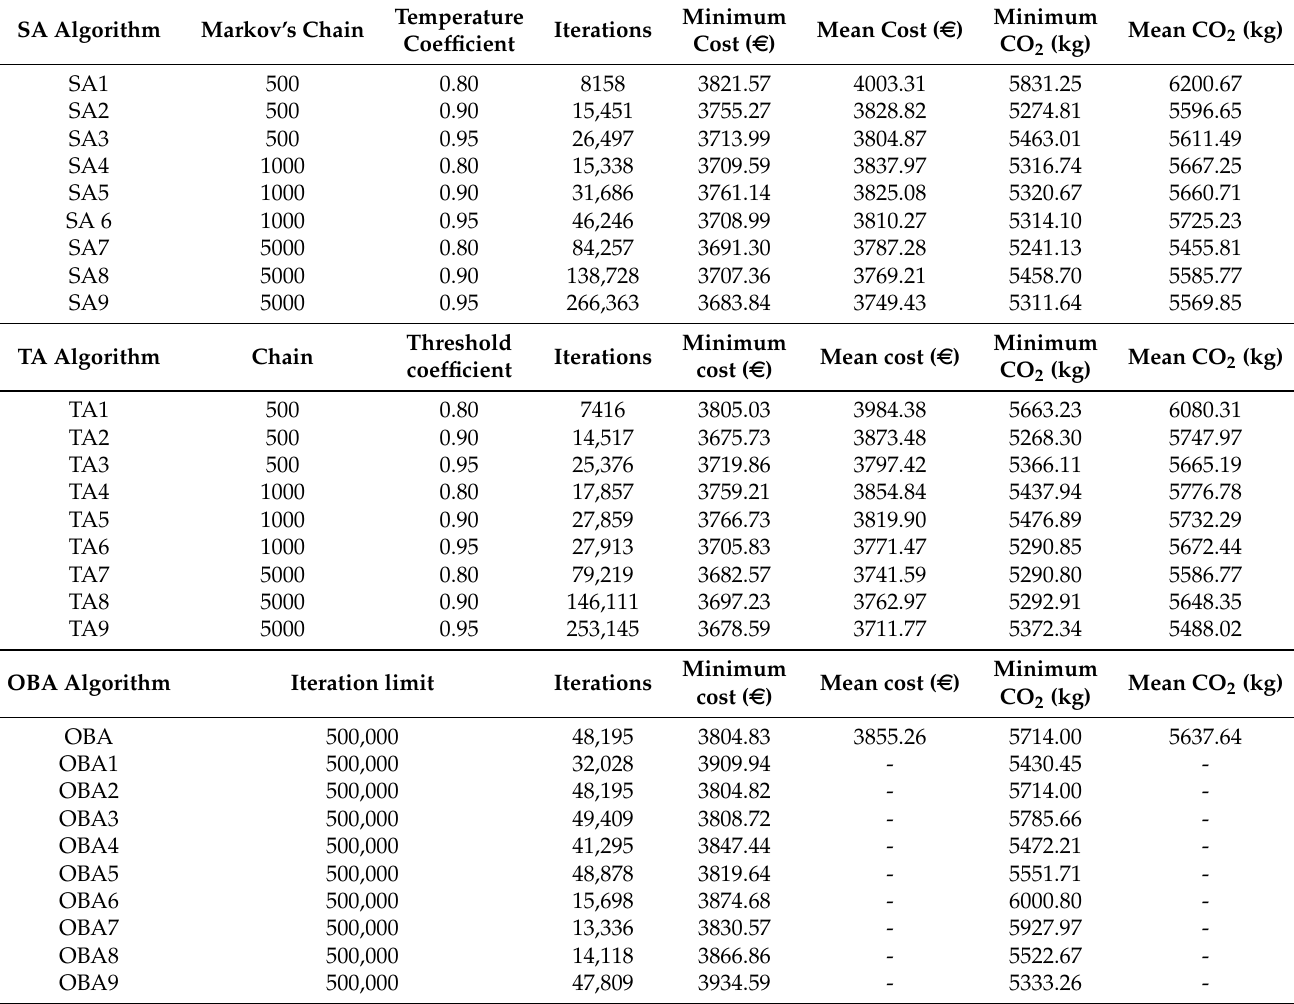
Table 4. Algorithm parameters in addition to the minimum and mean final cost and associated CO 2 emissions results